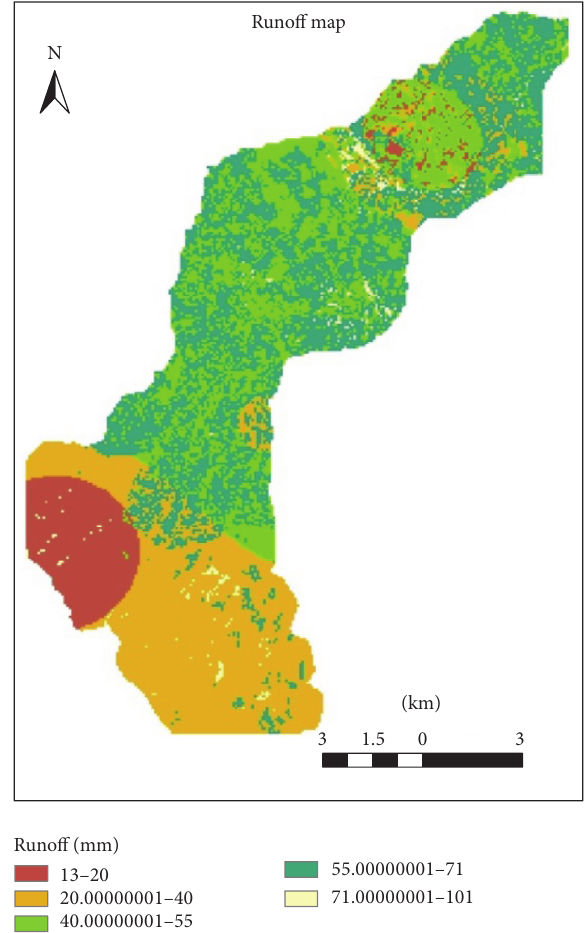
Figure 4: Curve number map.